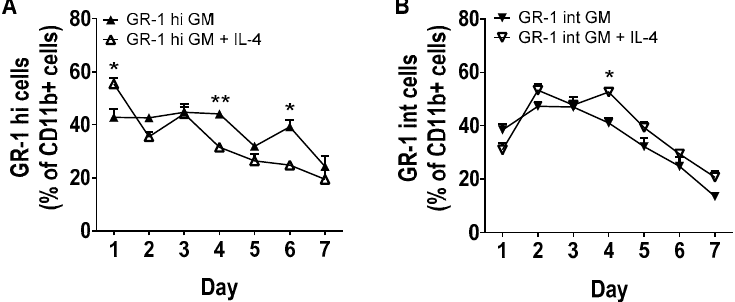
Figure 3. GM-CSF and GM-CSF + IL-4 cultures induce the generation of two subsets of MDSC. MDSCs (CD11c-, CD11b + , Gr-1 + cells) generated from murine BM with GM-CSF (10 ng / mL) (closed triangles) or GM-CSF (10 ng / mL) + IL-4 (5 ng / mL) (open triangles) from days 1-7. Cells were assessed for the percentage of ( A ) Gr-1 hi MDSCs and ( B ) Gr-1 int MDSCs generated within CD11c-, CD11b + cells. Results shown are from three mice, two-way ANOVA was used to compare both cultures at each time-point. Results displayed as mean +/ − SD, * p < 0.05, ** p < 0.01.